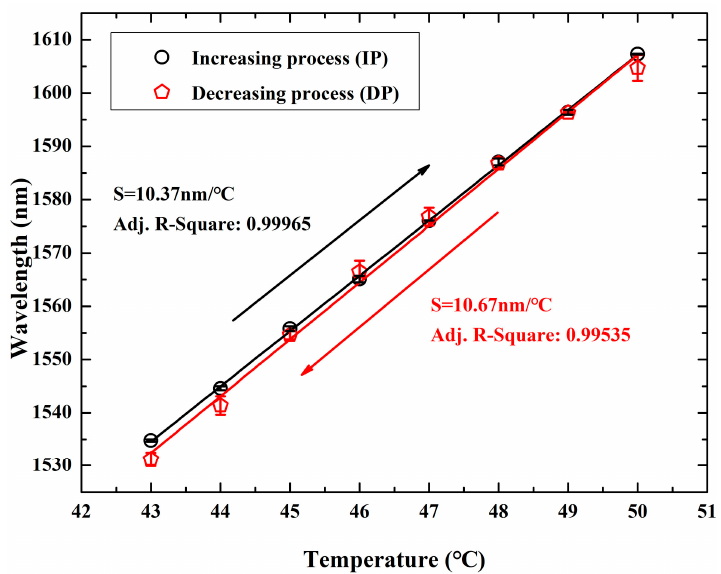
Figure 5. Location of resonance dip changed as a function of temperature with an excellent linear fitting during the increasing and decreasing process of 43–50 °C. The corresponding sensitivities were determined to be 10.37 nm/°C and 10.67 nm/°C, respectively.